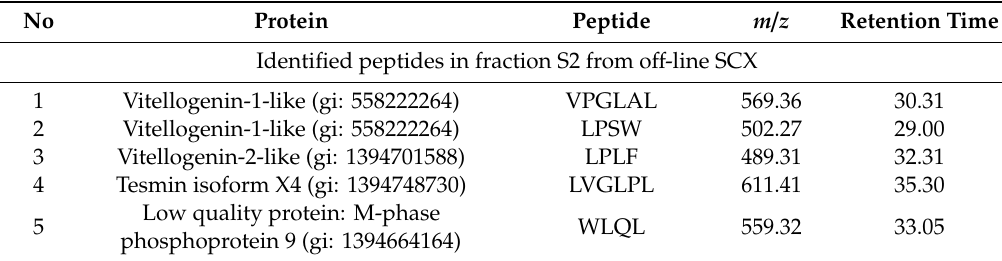
Table 1. List of the identified peptides discovered in SCX-S2, RP-R7, and RP-R13 fractions. No Protein Peptide m / z Retention Time Identified peptides in fraction S2 from o ff -line